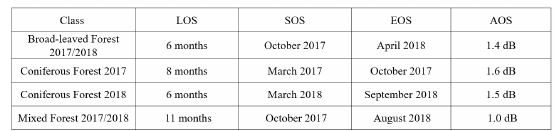
Table 3: calculated seasonal parameters of the tree